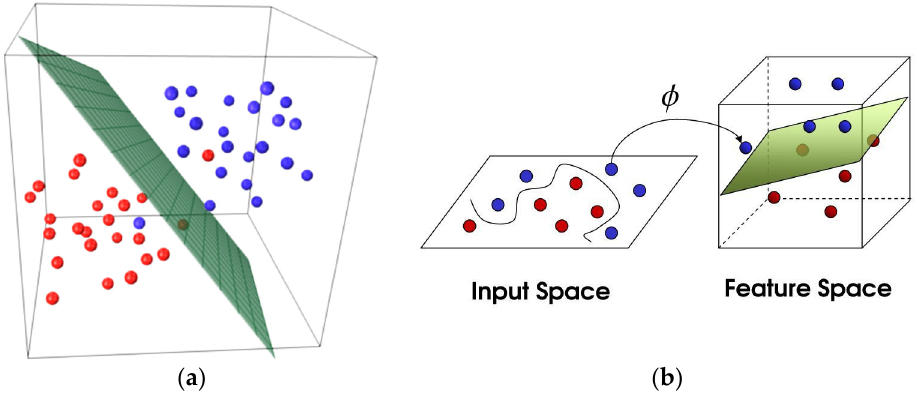
Figure 3. ( a ) Hyperplane that separate two classes of data, ( b ) kernel trick.